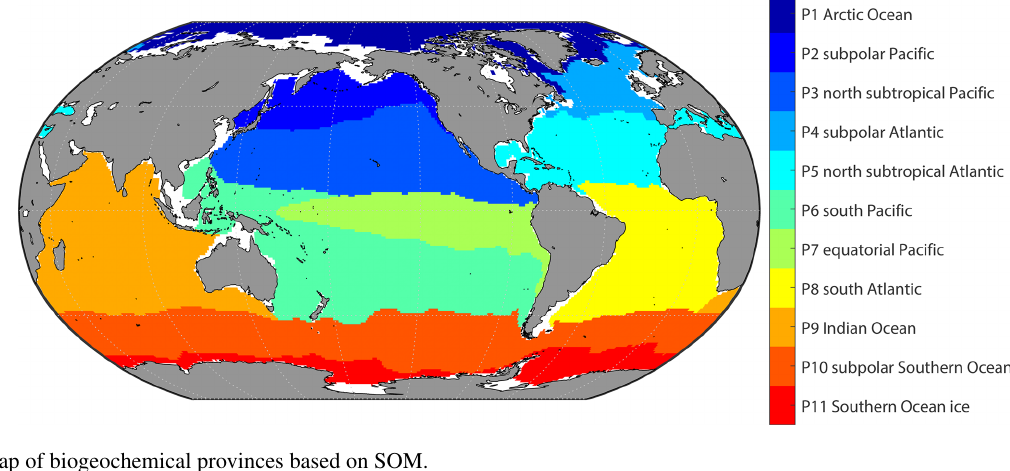
Figure 4. Map of biogeochemical provinces based on SOM.